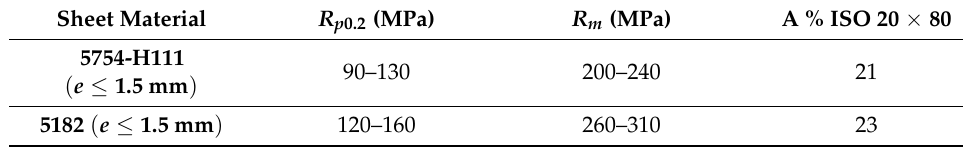
Table 3. Aluminum alloys mechanical properties.